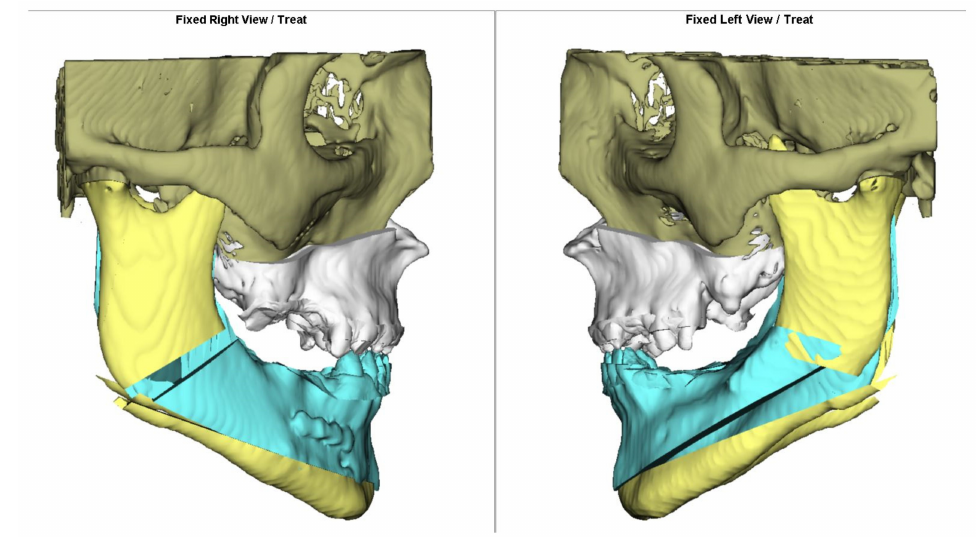
Figure 9. Digital